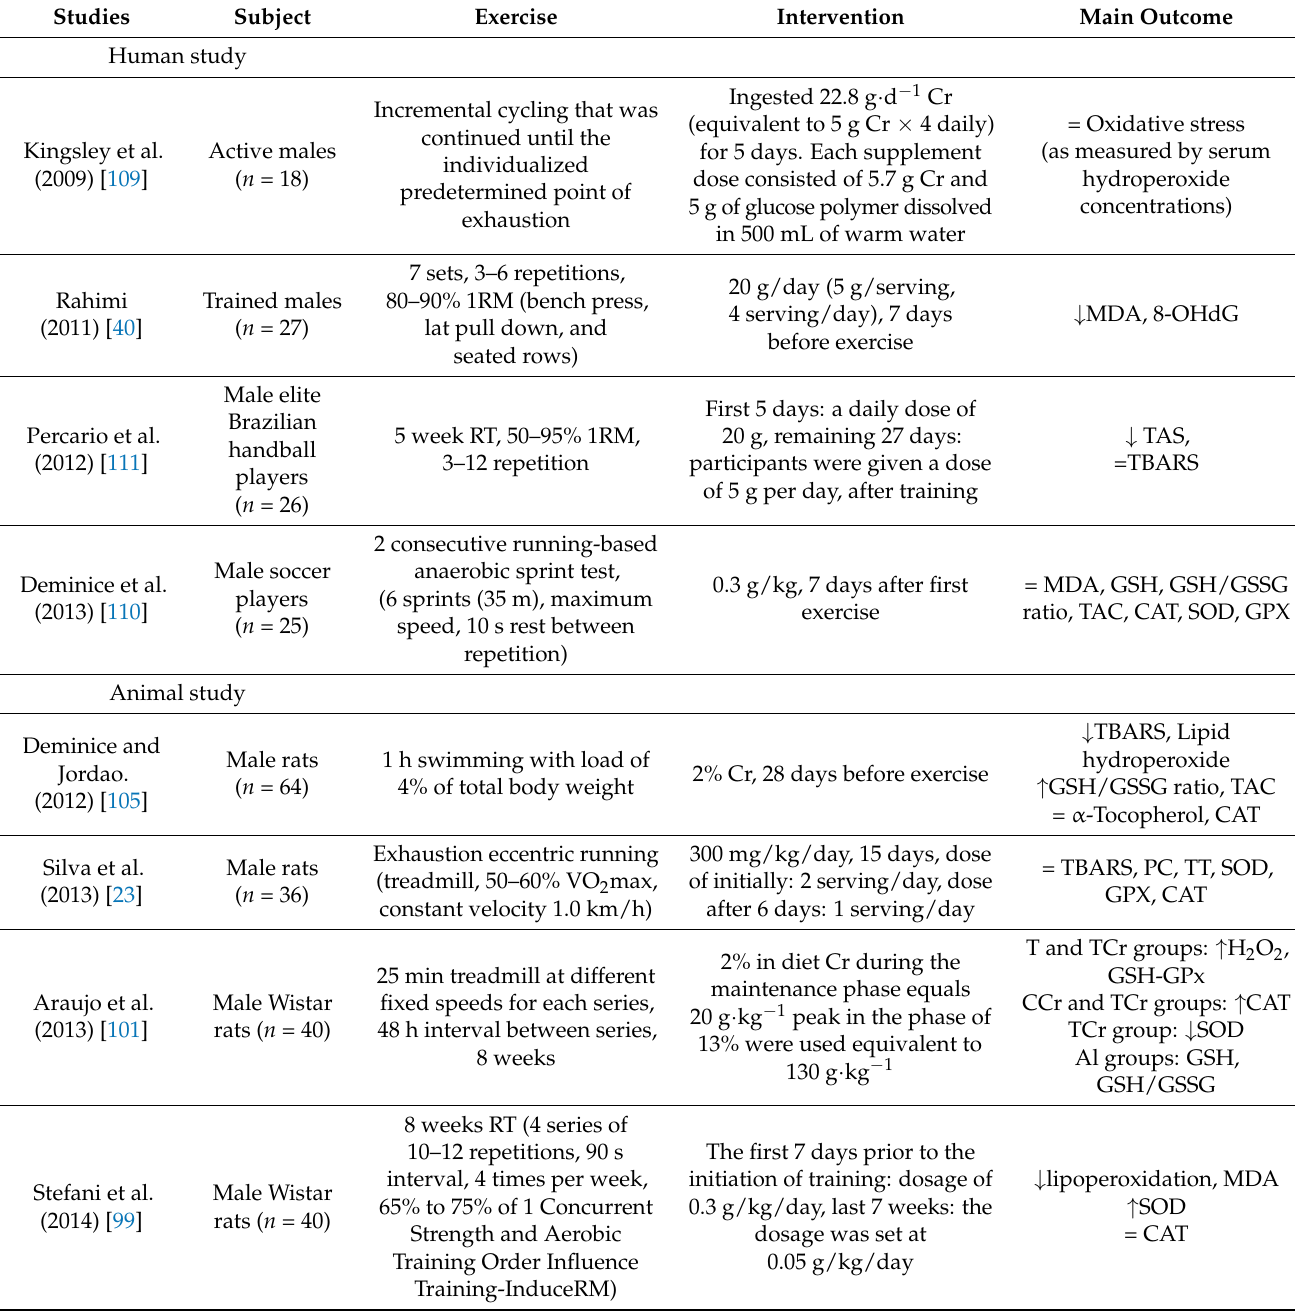
Table 1. Studies on the effects of short-term and long-term creatine supplementation and exercise on oxidative stress.